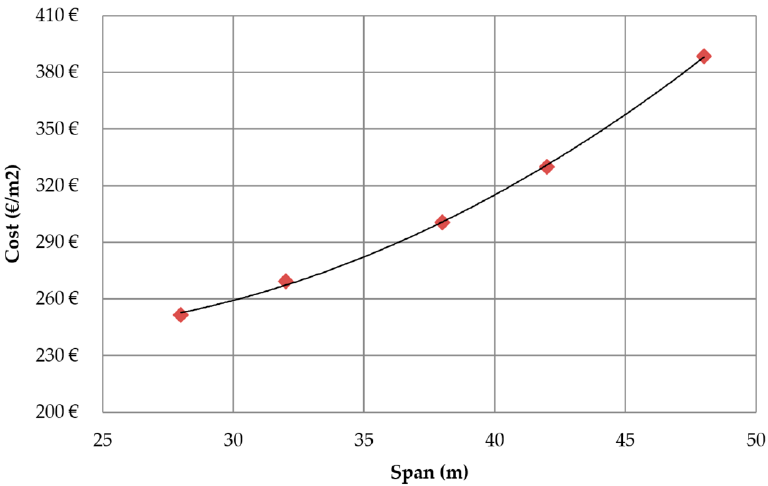
Figure 8. Average cost for different span lengths.